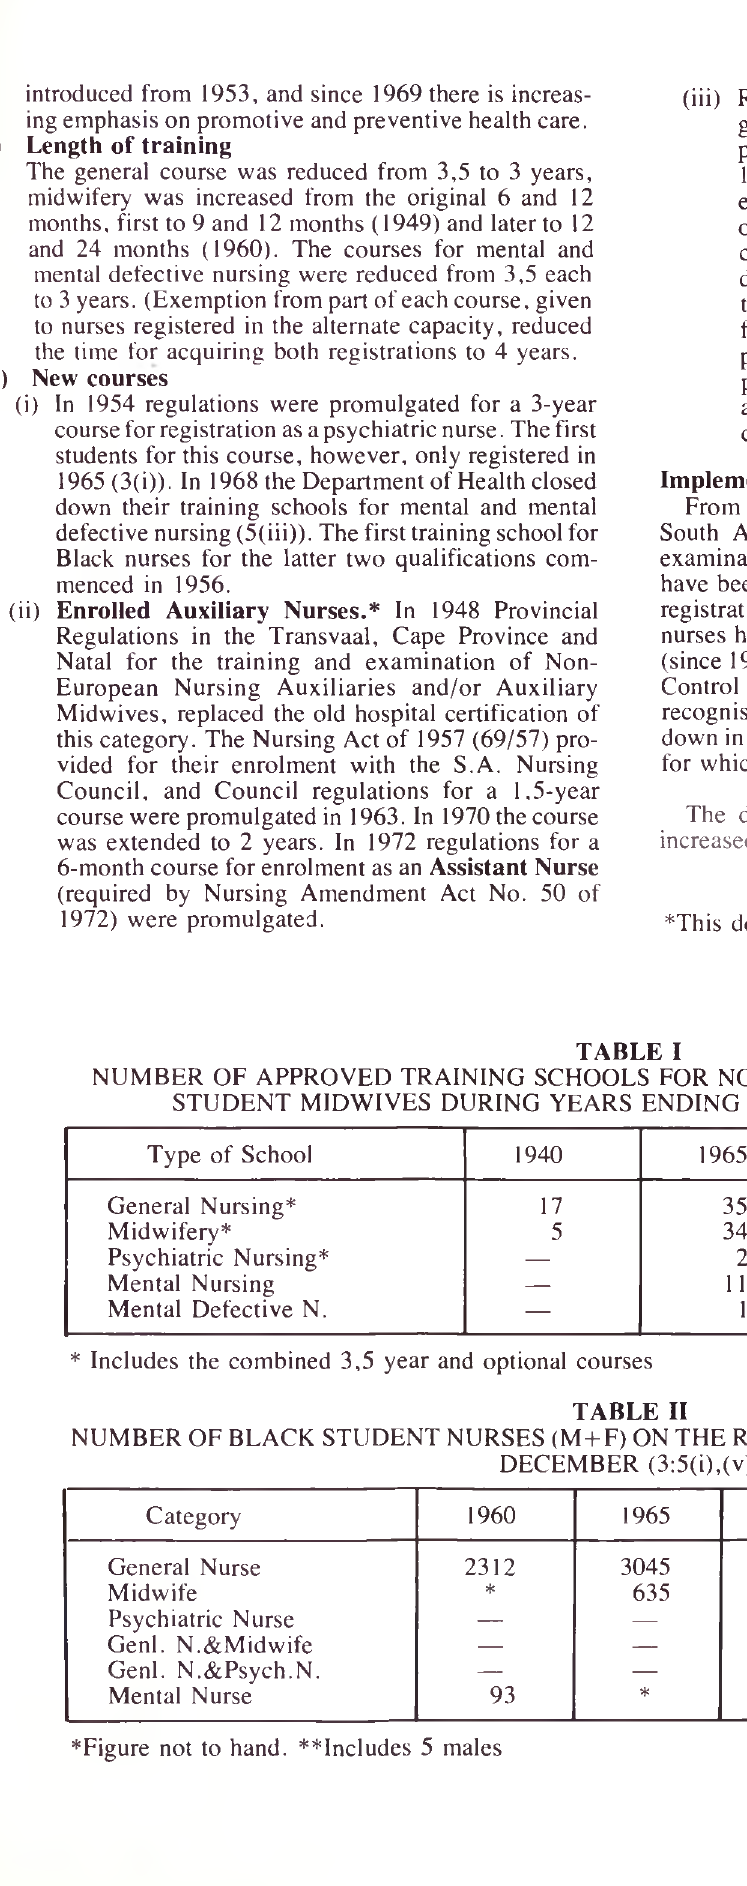
NUMBER OF BLACK STUDENT NURSES (M +F) ON THE REGISTERS IN THE YEARS ENDING 31